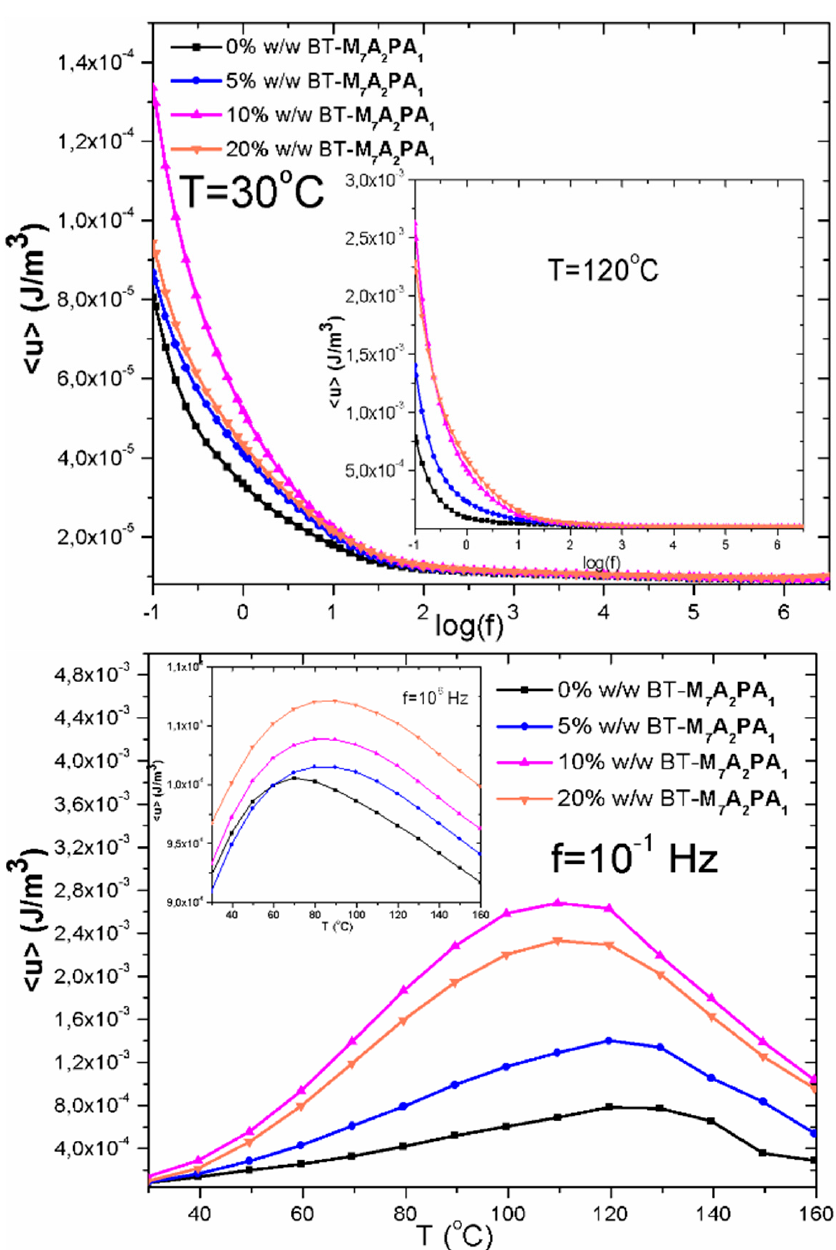
Figure 12. Comparative graphs of energy density versus frequency ( up ), at 30 °C and 120 °C ( inset ), and versus temperature ( down ), at 10 − 1 Hz and 10 6 Hz (inset), for the M 7 A 2 PA 1 -BT nano- composites.